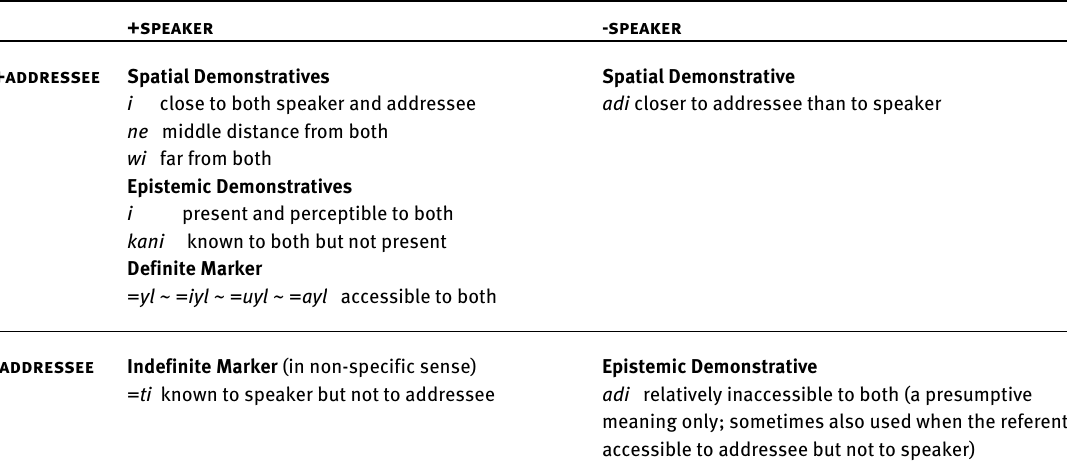
Table 1. Ku Waru engagement markers and their intersubjective